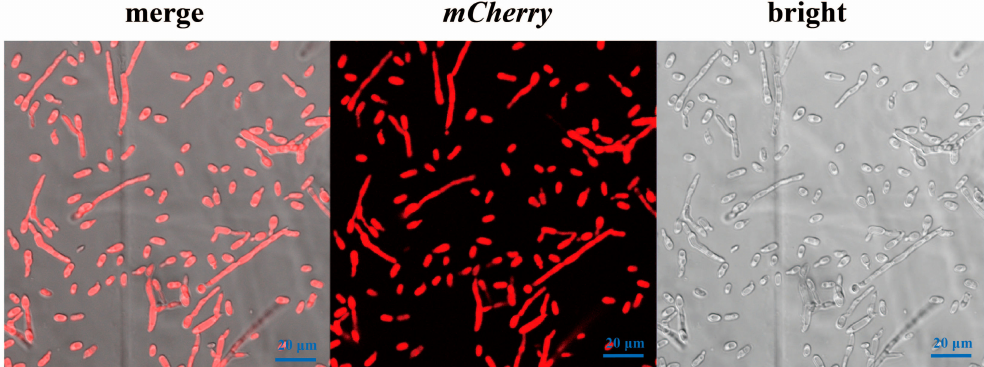
Figure 2. Confocal micrograph of red fluorescence by mCherry -labeled Verticillium dahliae ( Vd-m ).